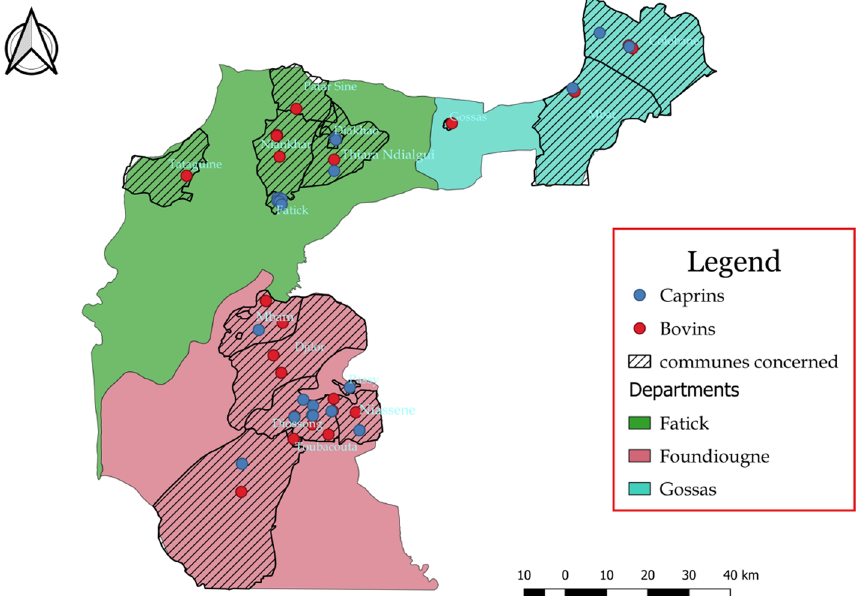
Fig. 1 Geographic location of women interviewees (caprine and bovine value chain) from the Fatick region of Senegal (Departments: Fatick, Foundiougne,